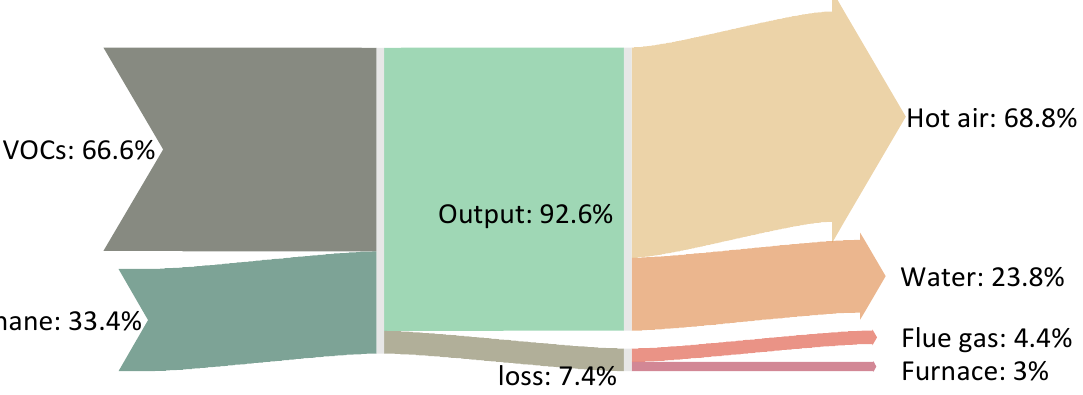
Figure 5. Flow diagram of energy distribution.